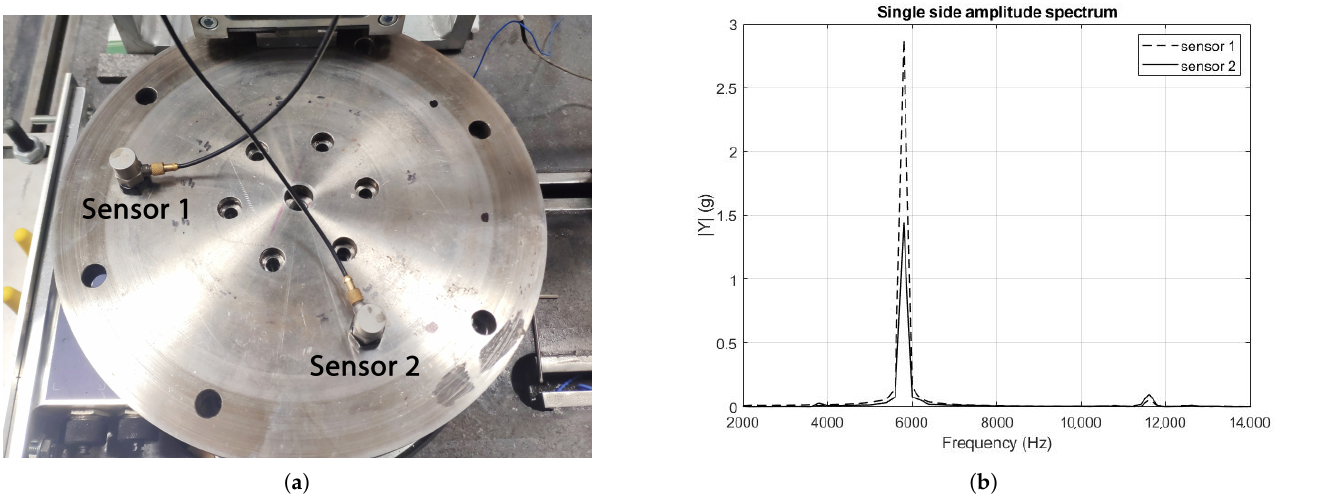
Figure 6. ( a ) Sensor positions for brake squeal measurement and ( b ) single-side amplitude spectrum of the measured squeal signal